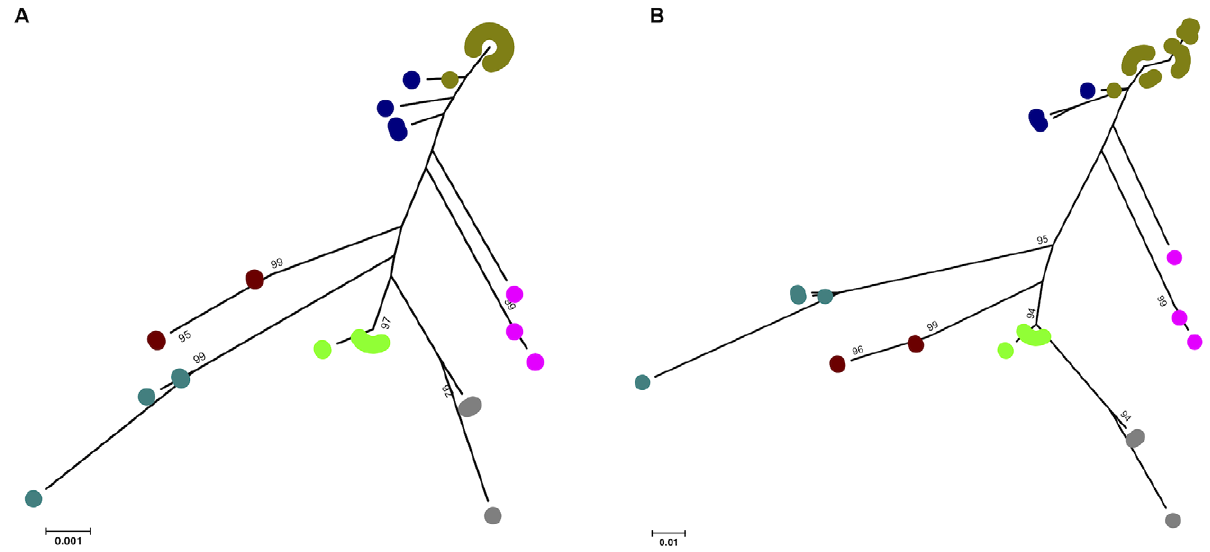
Figure 4. Phylogenetic trees based on the near full-length rrs gene. Neighbor-joining (A) and maximum likelihood (B) trees were constructed using the near full-length rrs gene of 100 isolates representing 7 pathogenic Leptospira species. Two isolates of L. kirschneri were misclassified as L. interrogans by rrs . Note the diversity of rrs sequences within L. noguchii species. Color code: khaki, L. interrogans ; dark blue, L. kirschneri ; pink, L. nogouchii ; dark green, L. santarosai ; light green, L. borgpetersenii ; brown, L. alexanderi ; grey, L. weilli .